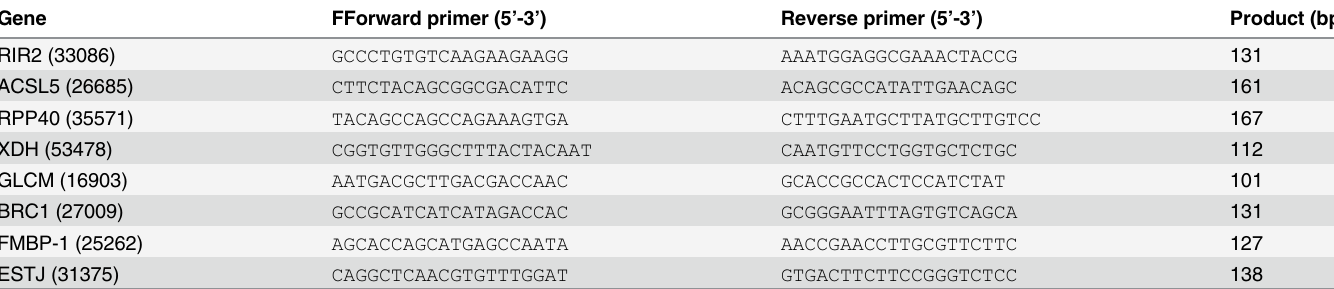
Table 1. Primers used for qRT-PCR validation, all with Tm = 55°C. Gene IDs are in parenthesis.